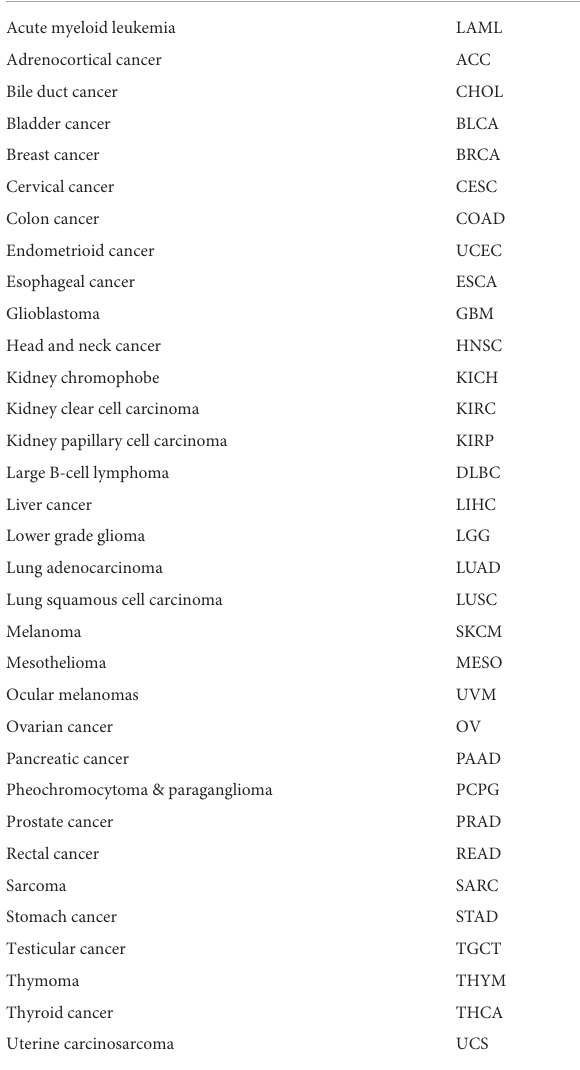
TABLE 1 33 different cancer types and its